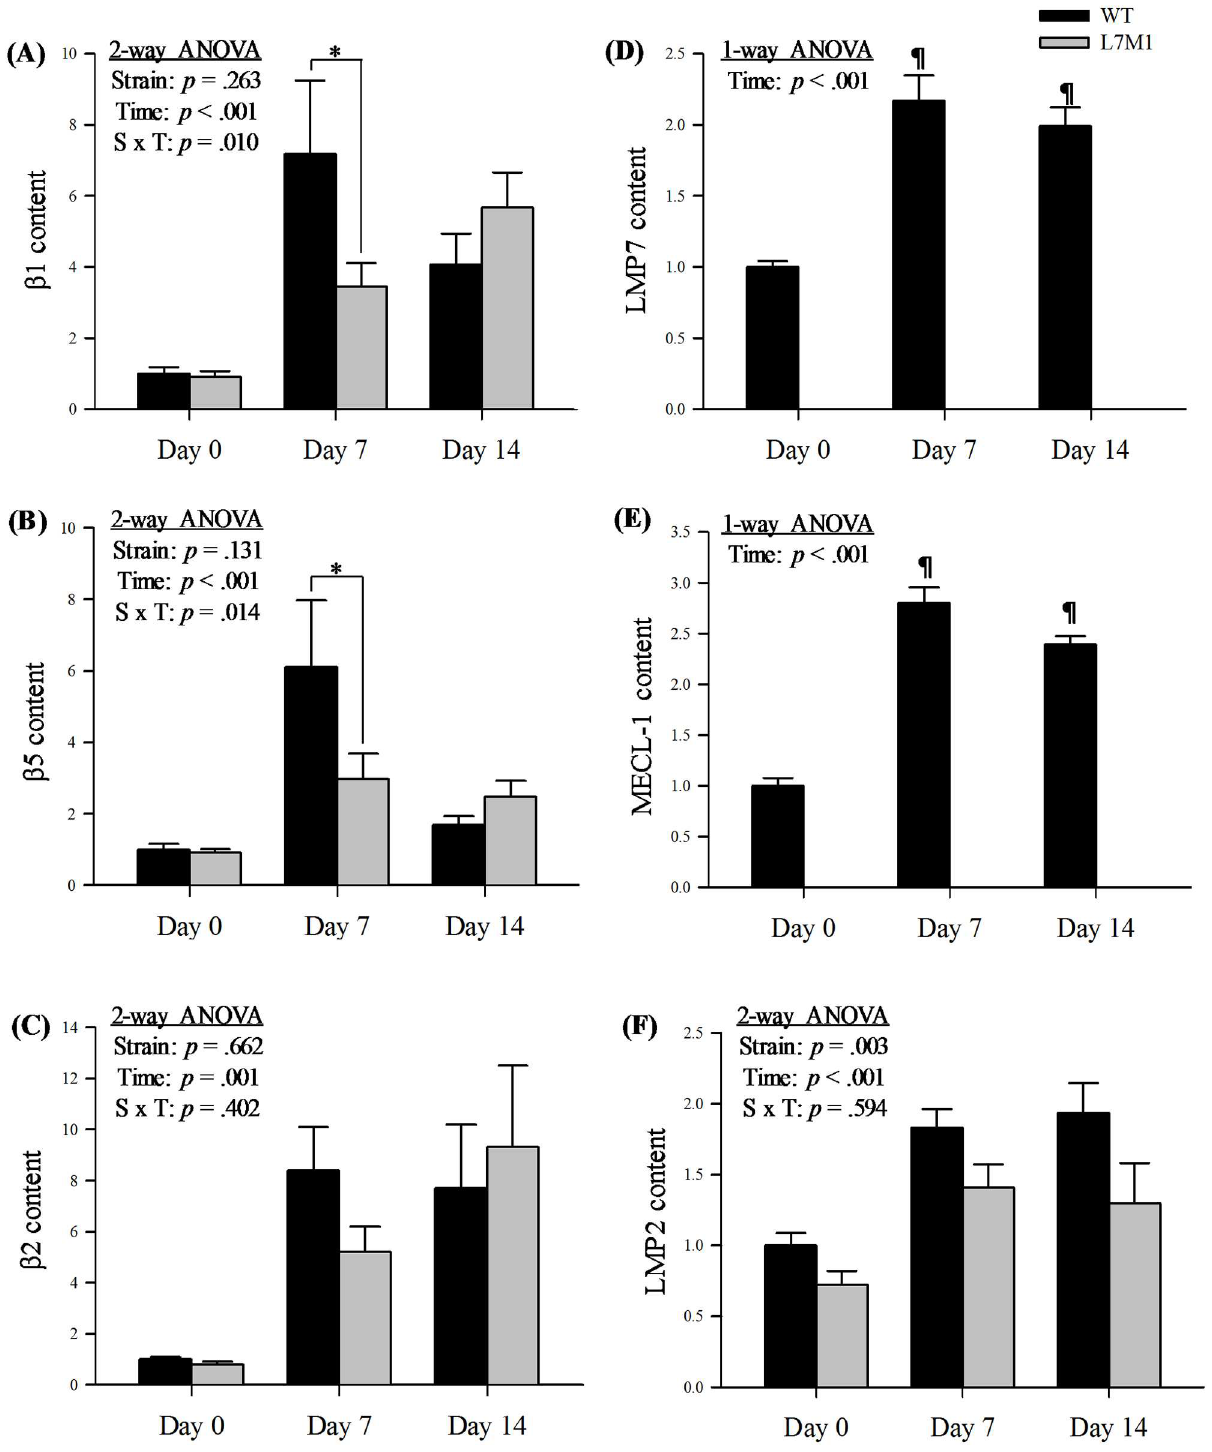
Fig 4. Protein content of standard catalytic and immunoproteasome subunits in WT and L7M1 mice with denervation. Results of densitometry are presented as the fold changecomparedto WT Day 0 for each respectiveprotein. (A-C) Standardcatalytic subunits. Each panel containsresults of two-way ANOVA that were used to detect the effect of strain (WT vs. L7M1) and time (Day 0, 7, and 14) for (A) β 1, (B) β 5, and (C) β 2 (# indicatessignificanteffect of strain/time/S x T interactions, p < .05). When an effect of interactionwas detected, a Fisher’s LSD post-hoc test was followedto comparedifferences betweenstrains at each time point ( * indicatesL7M1 is significantdifferent